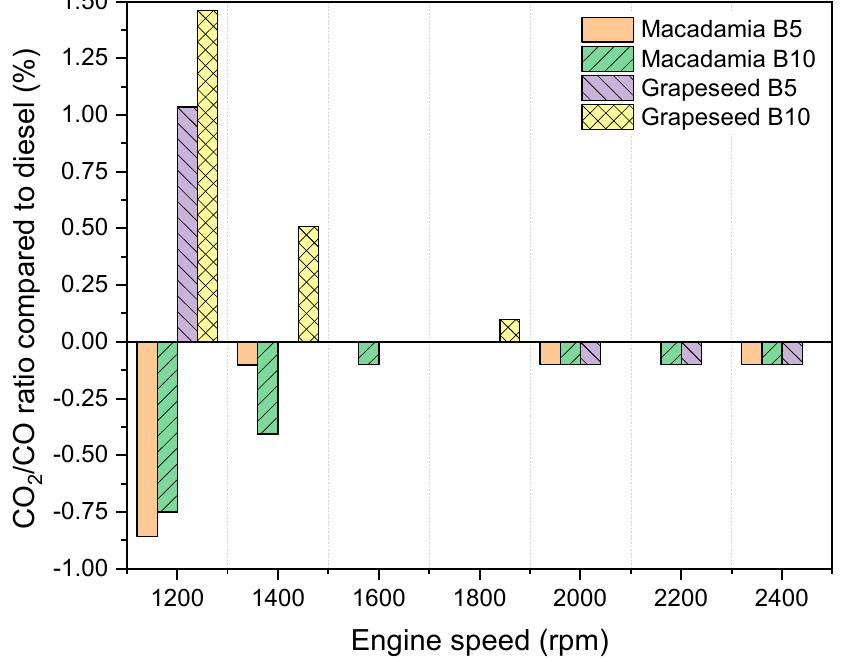
Figure 6. Variation of CO 2 / CO ratio balancing with the variation of engine speed.